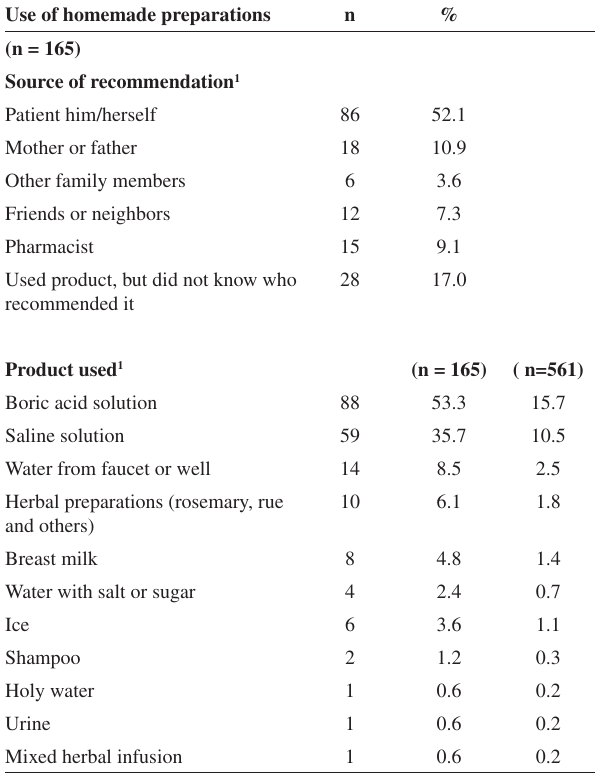
Table 2 - Use of homemade medicines in the eye prior